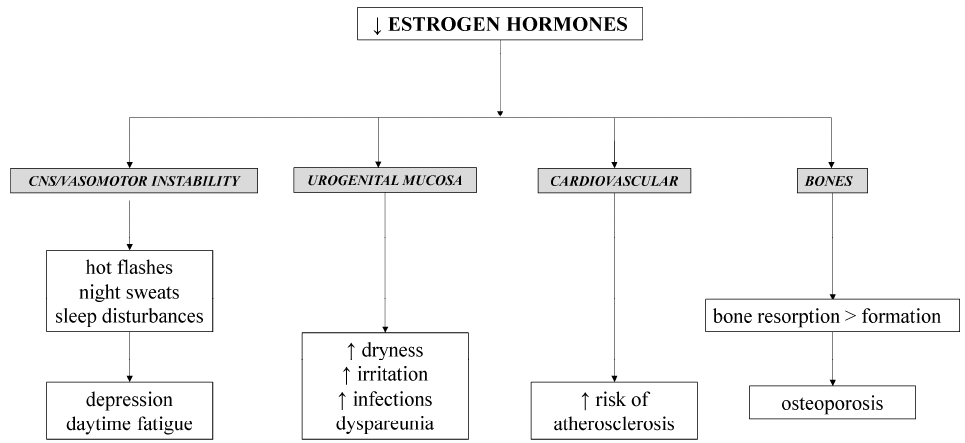
Scheme 1 . Menopause symptoms as a result of progressive decline of